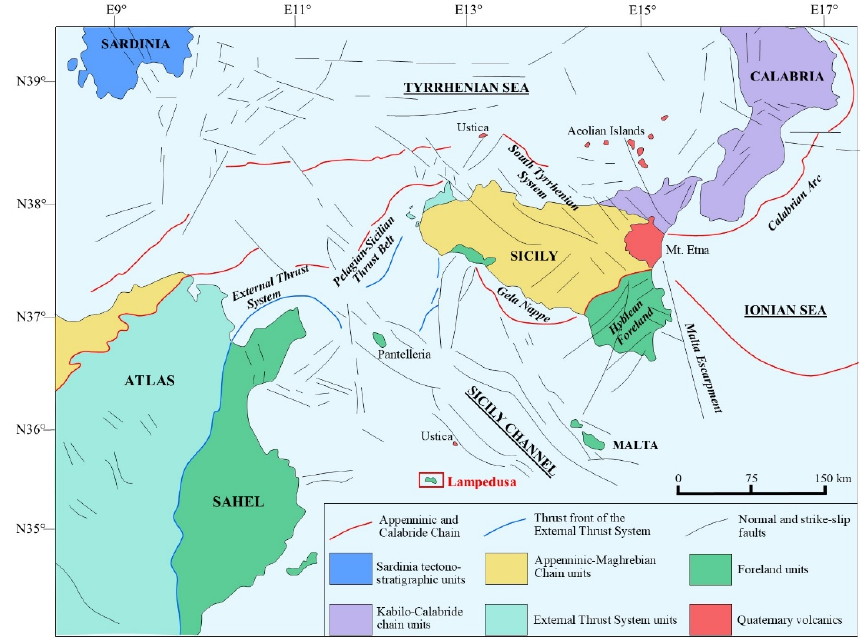
Figure 2. Geological setting of the Sicily Channel.